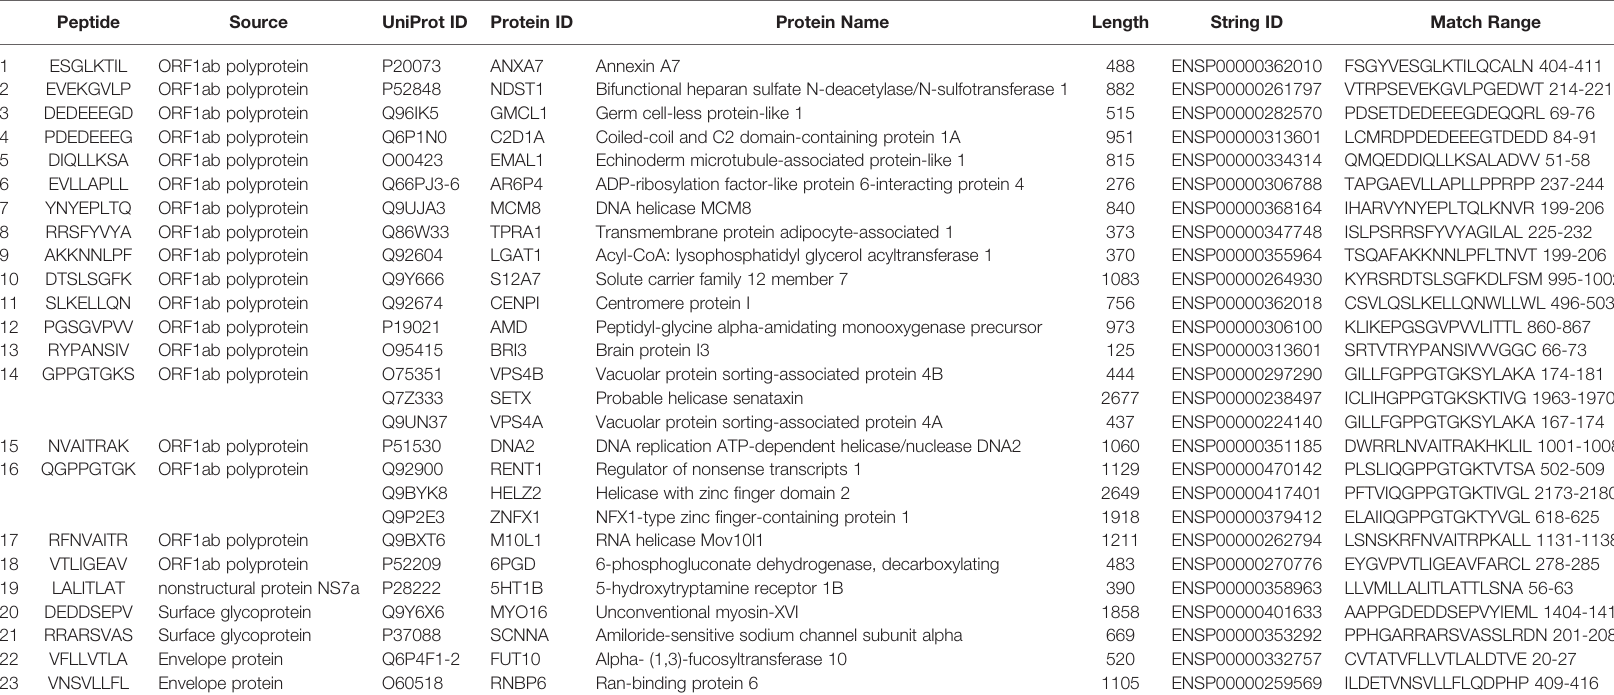
TABLE 1 | The results of peptide (octamers) similarity search between SARS-CoV-2 peptides and human